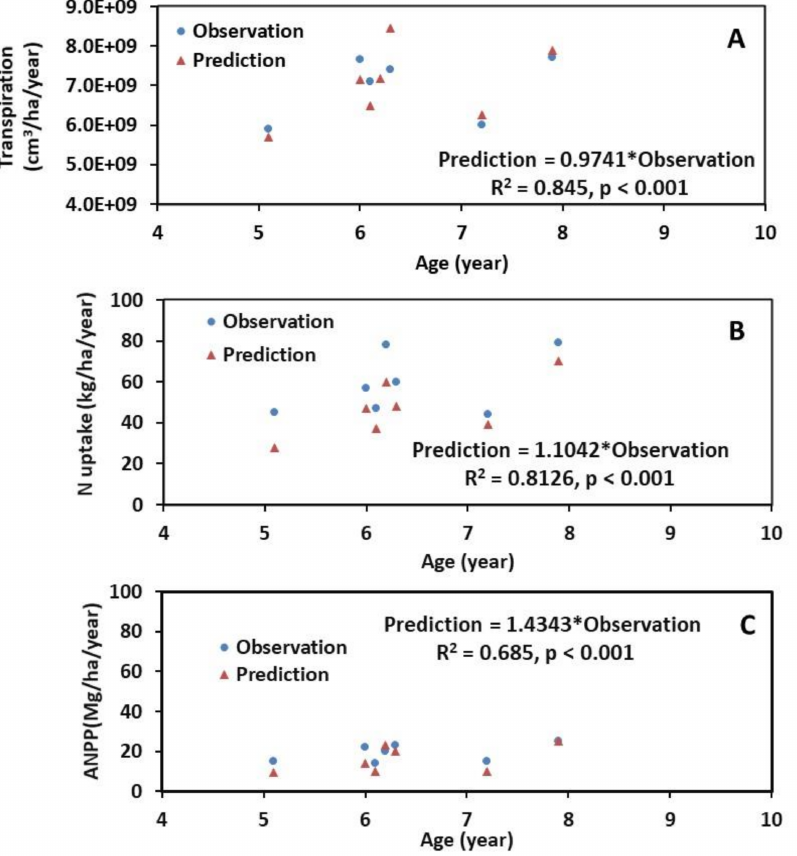
Figure 4. Comparison of model-predicted and field measured transpiration ( A ), N uptake ( B ), and ANPP ( C ) during the model